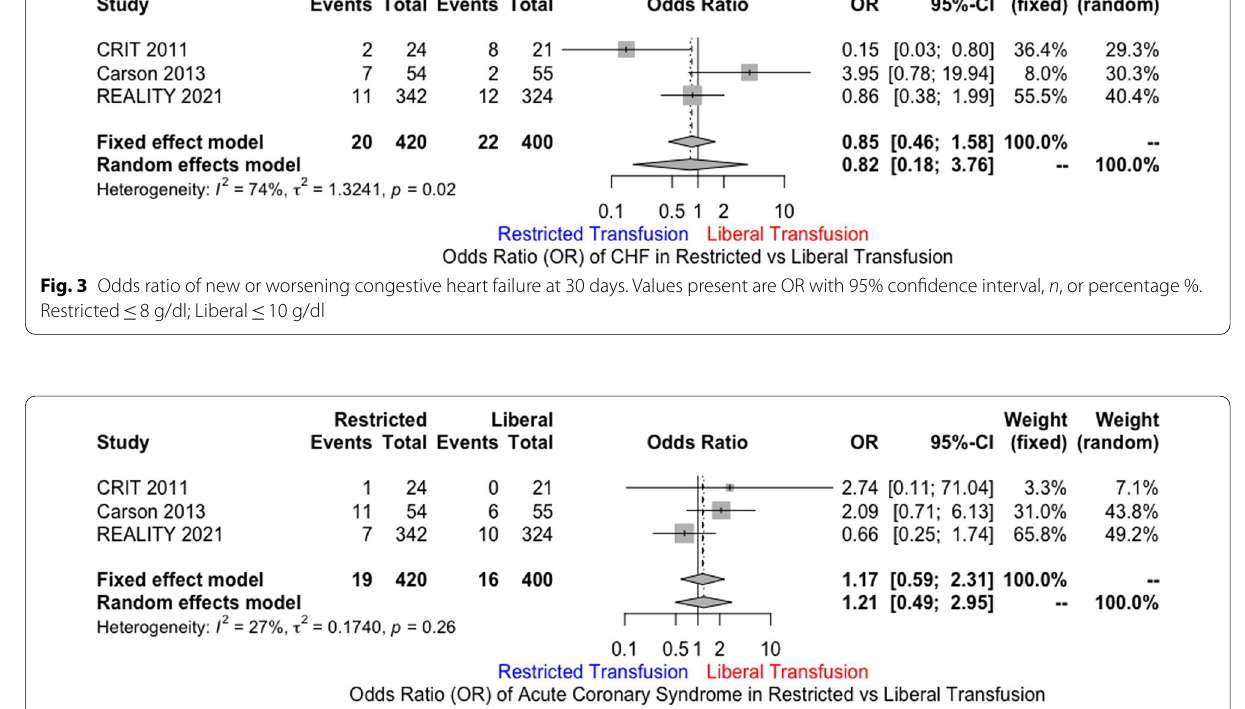
Fig. 4 Odds ratio of recurrent acute coronary syndrome at 30 days. Values present are OR with 95% confidence interval, n , or percentage %. Restricted 8 g/dl; Liberal 10 ≤ ≤